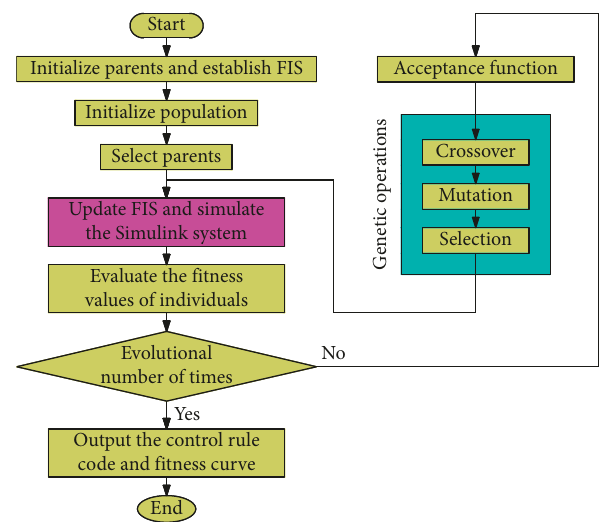
Figure 6: The flow chart of the GA program for